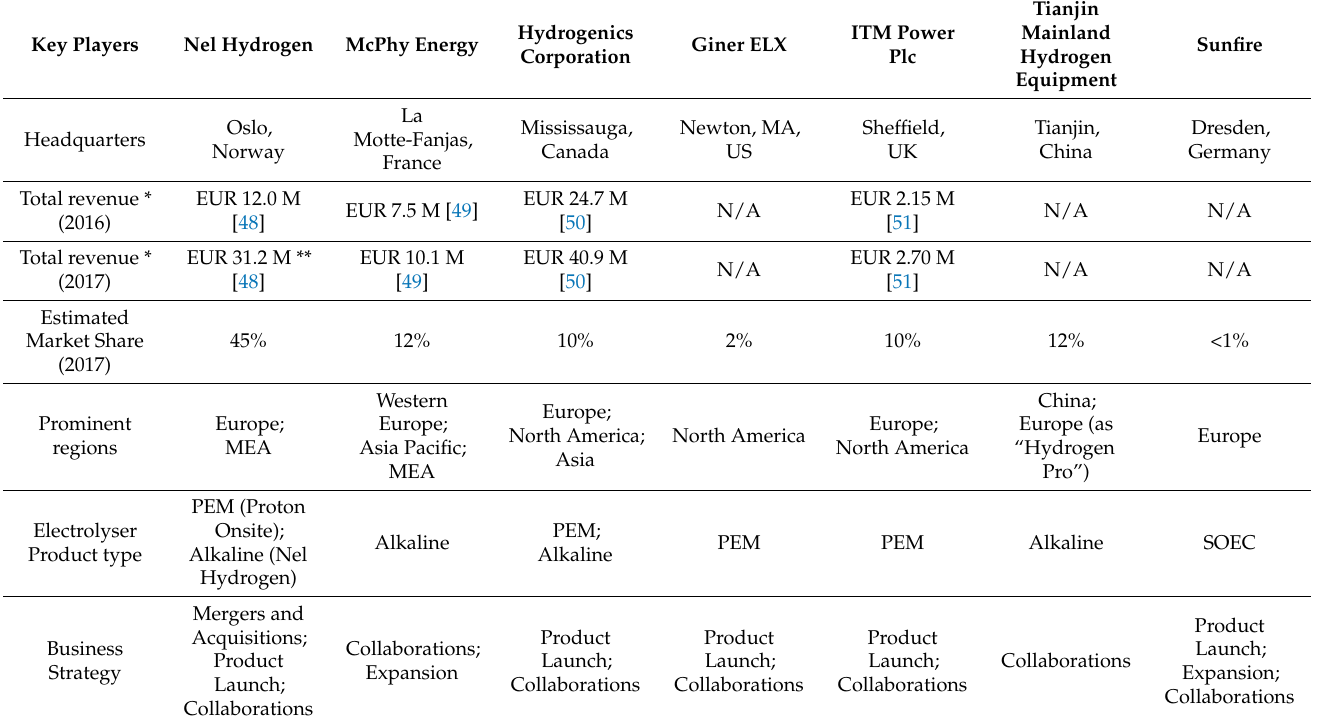
Table 2. Key players within the global electrolyser industry